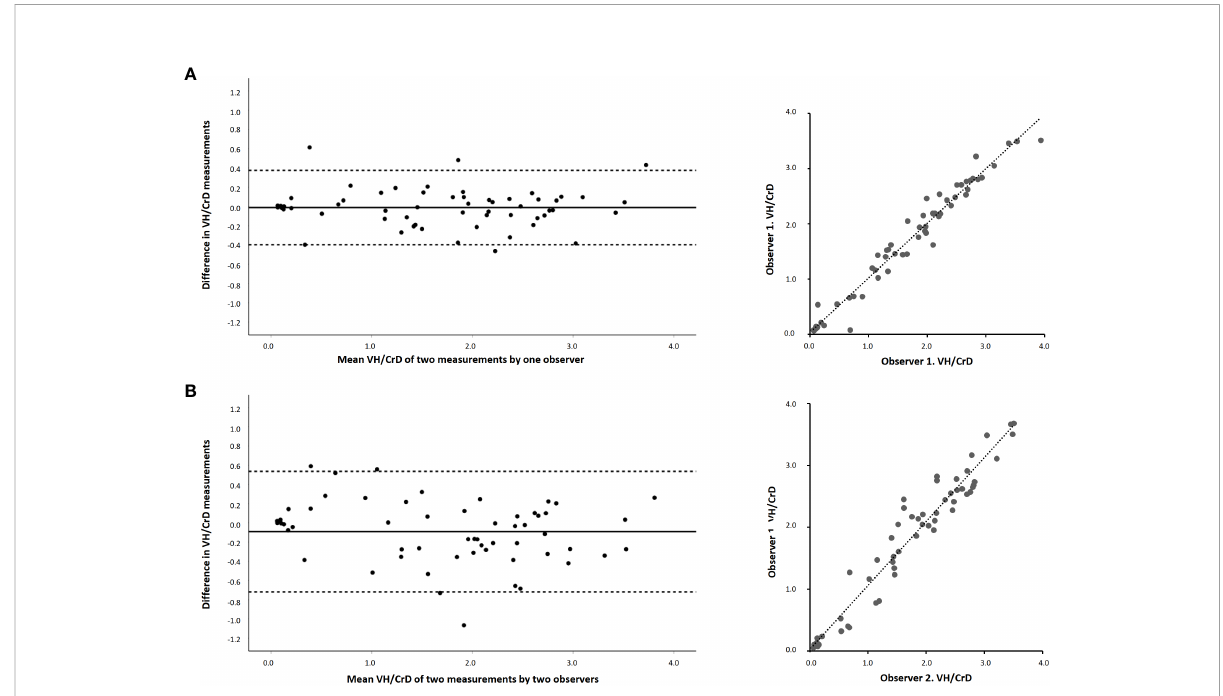
FIGURE 2 Bland – Altman plots and linear regressions of the morphological measurements of duodenal mucosa with micro-CT imaging by two blinded readers. The panels show villous height crypt depth ratios (VH : CrD) between intraobserver (A) and interobserver (B) measurements. The x-axis in Bland – Altman shows the mean of the measurements, and the y-axis differences between the measurements. Solid horizontal lines denote the average difference between the readers and dotted lines 95% limits of agreement.